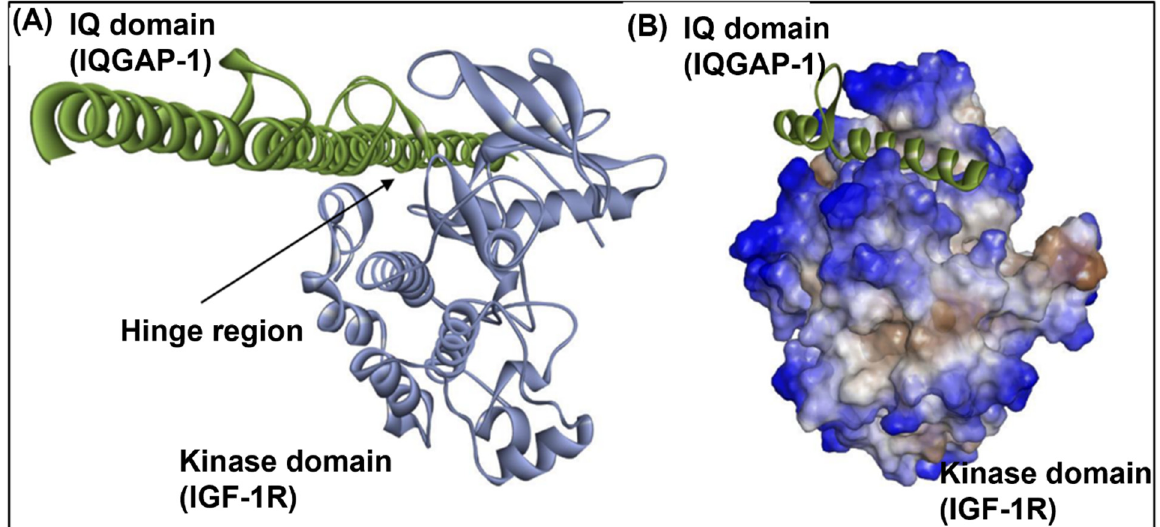
Figure 9. Docked poses of IQGAP1 and IGF1-R through their IQ (modeled) and kinase (PDB ID: 1JQH) domains, respectively. ( A ) represents the interaction of the IQ domain (pale green) and kinase domain (pale blue) in a cartoon view, and ( B ) represents the interaction of the IQ domain (pale green) with the hydrophobic surface (brown hydrophobic and blue hydrophilic) of the kinase domain.